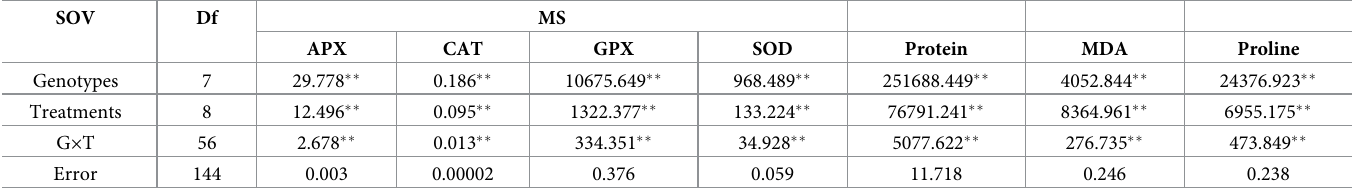
Table 3. Mean sum of squares for antioxidant enzymes, protein, MDA and proline of eight mung bean genotypes grown under Cd and pretreatments of GA 3 , SA and proline prior to Cd for 1 week. SOV